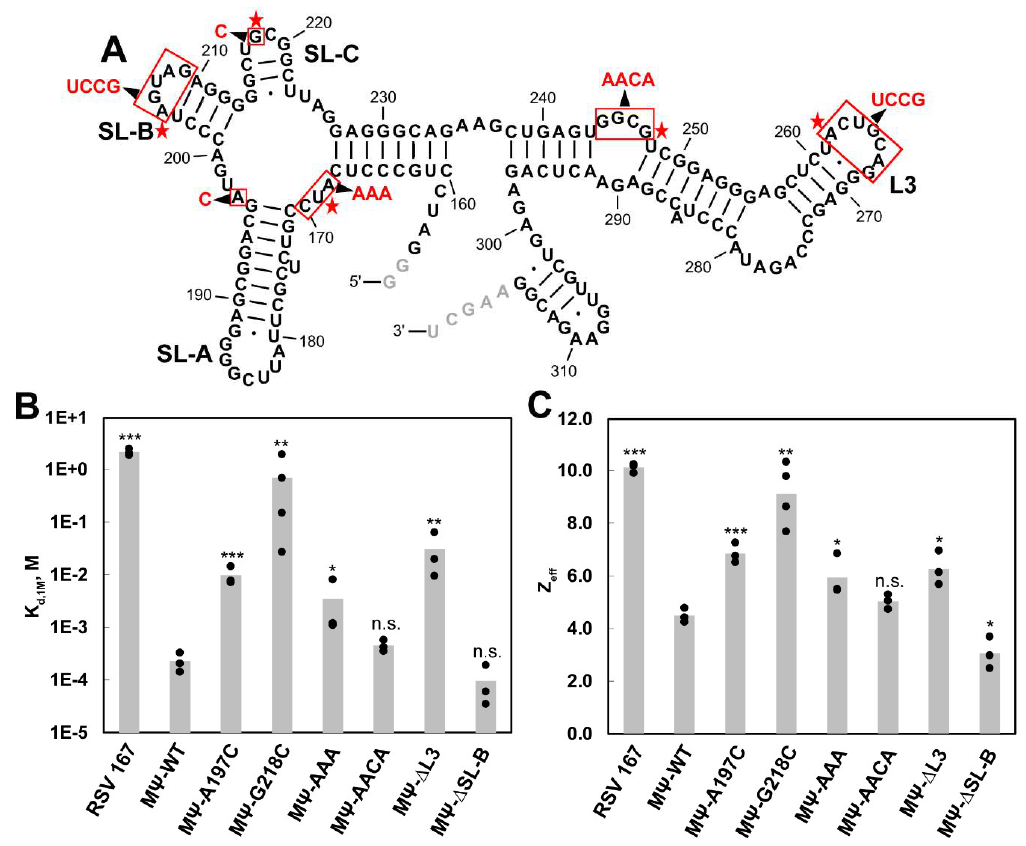
Figure 5. ( A ) Secondary structure of RSV MΨ. Six mutant MΨ constructs tested are indicated by red boxes and black arrows. Additional nucleotides that were added to facilitate in vitro transcription are shown in grey. ( B,C ) Bar graphs of K d,1M (B) and Z eff (C) values determined by fluorescence anisotropy (FA) salt titration binding assays using RSV Gag∆PR and RSV 167, MΨ-WT and six MΨ mutants. Values of three to four trials are indicated by black dots and the average is indicated by the height of the bar. p values were determined in comparison with MΨ-WT using unpaired, two-tailed student t-tests. (***) p < 0.001; (**) p < 0.01; (*) p < 0.05; (n.s.) not significant.